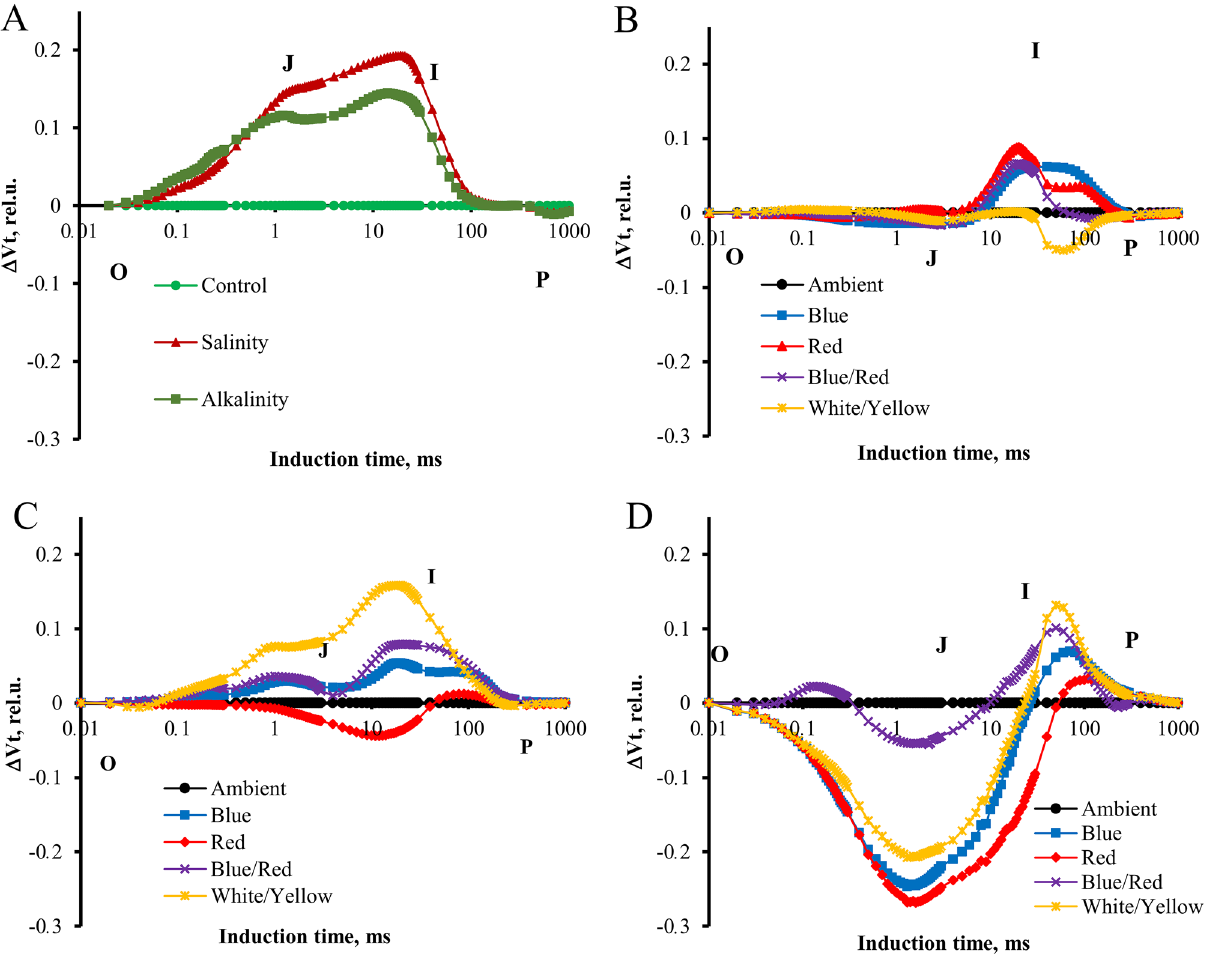
Figure 3. Differential curves of ΔV t of chlorophyll a fluorescence of strawberry cv. Paros. ( A ) In ambient light (control, salt stress, alkalinity stress); ( B ) non-stressed in different light spectra (ambient, blue, red, blue/ red, white/yellow); ( C ) under salt stress in different light spectra (ambient, blue, red, blue/red, white/yellow); ( D ) under alkalinity stress in different light spectra (ambient, blue, red, blue/red, white/yellow). Biophysical parameters were determined with "PEA Plus" software version 1.12 (http:// www. hansa tech- instr uments. com). The graphs were drawn using Microsoft Excel version 2016 (https:// www. micro soft.